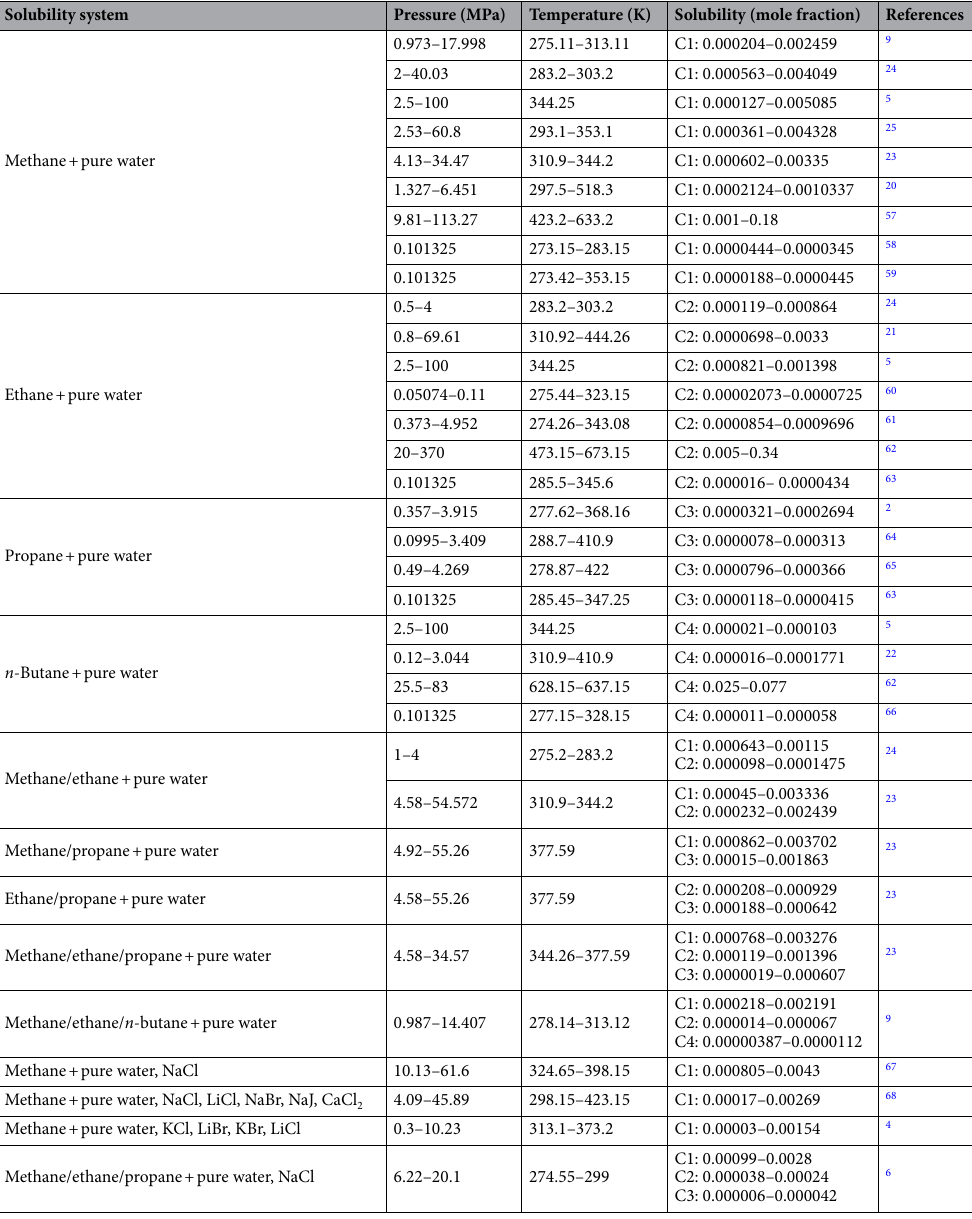
Table 1. The solubility systems of light hydrocarbon gases in pure water and aqueous electrolyte